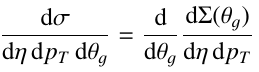
Figure 4. The soft drop groomed jet radius θ g (dashed black, yellow band) in proton-proton collisions at √ s Figure 3. Comparison with the ATLAS data [26] for the soft drop groomed jet mass distribution at √ s = 13 TeV.